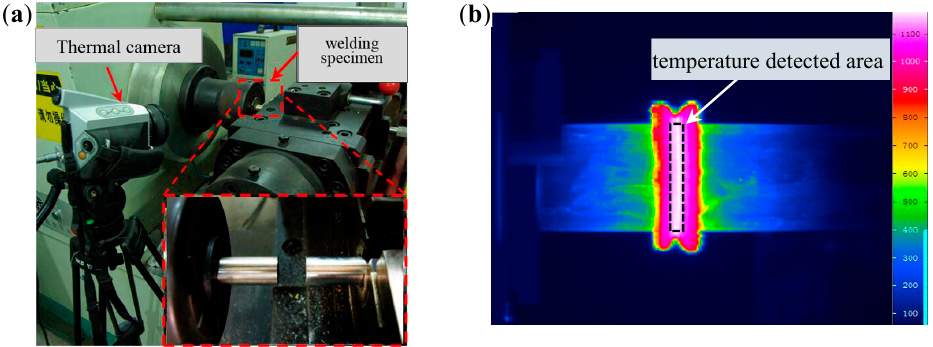
Figure 1. The ( a ) image of experimental equipment and ( b ) diagram of temperature detected area.